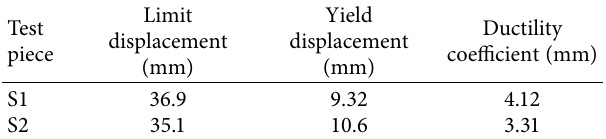
Figure 8: Load curve of the test piece: (a) skeleton curve of the test piece and (b) stiffness change of test pieces 1 and 2 during positive and negative loading of the test piece. Table 3: Comparison of ductility coefficient of the test piece.